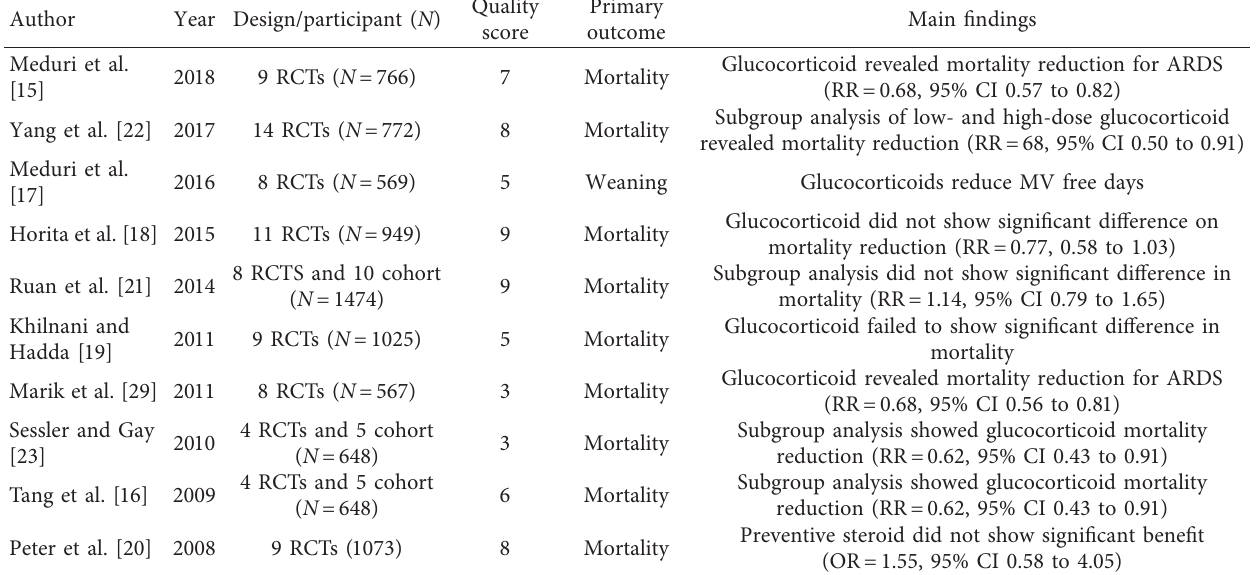
Table 2: Description of included studies.